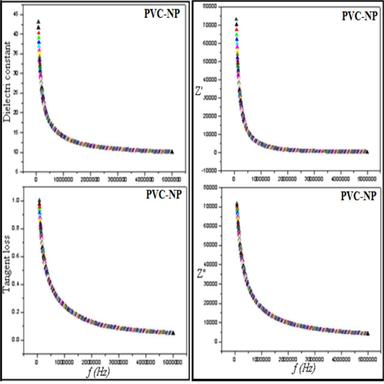
Dielectric (constant and loss) of PVC–NP composite membrane.